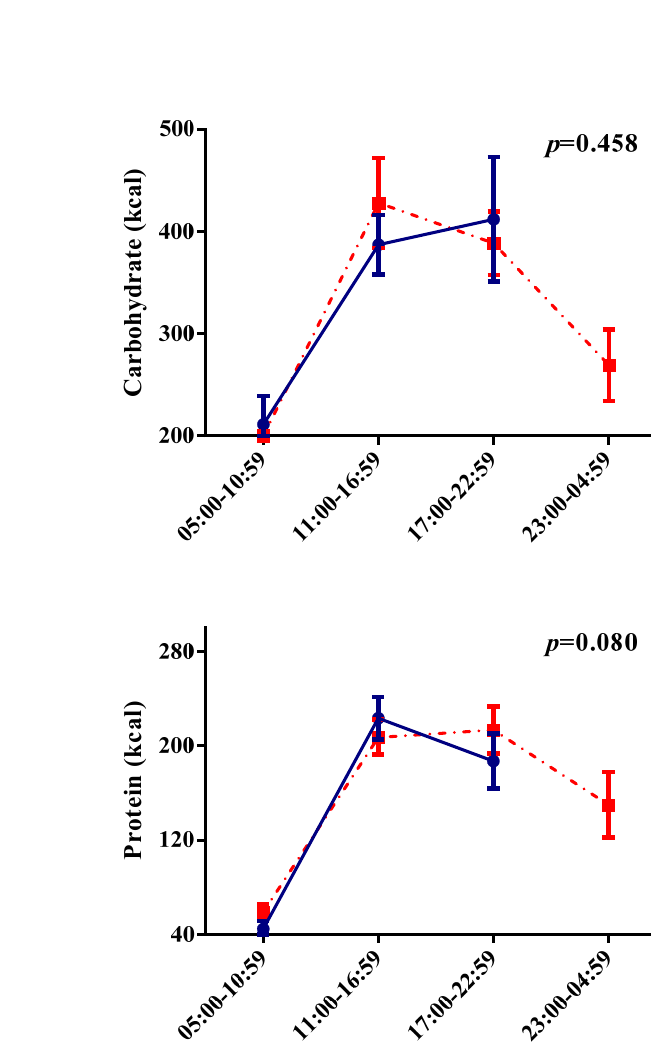
Figure 1. Energy and macronutrients distributed in periods according to the shift. Data represented as mean and confidence interval. Generalized Estimated Equations (GEE) were used to analyze the interaction ( p -value in the figure) between shifts and the distribution of energy and macronutrients in periods. Sequential Sidak post hoc was used, and the analysis was adjusted for age and BMI. p -interaction values < 0.05 were accepted as significant. Catarina–cc